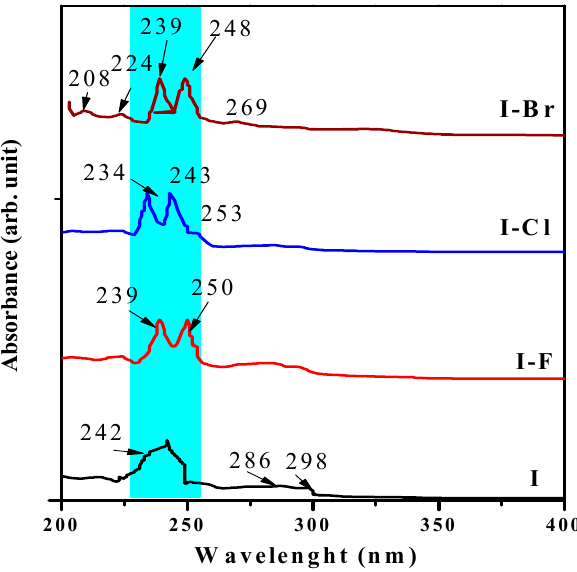
Figure 7. Absorbance vs. wavelength (nm) spectra of I , I − F , I − Cl , and I − Br samples in solid state.